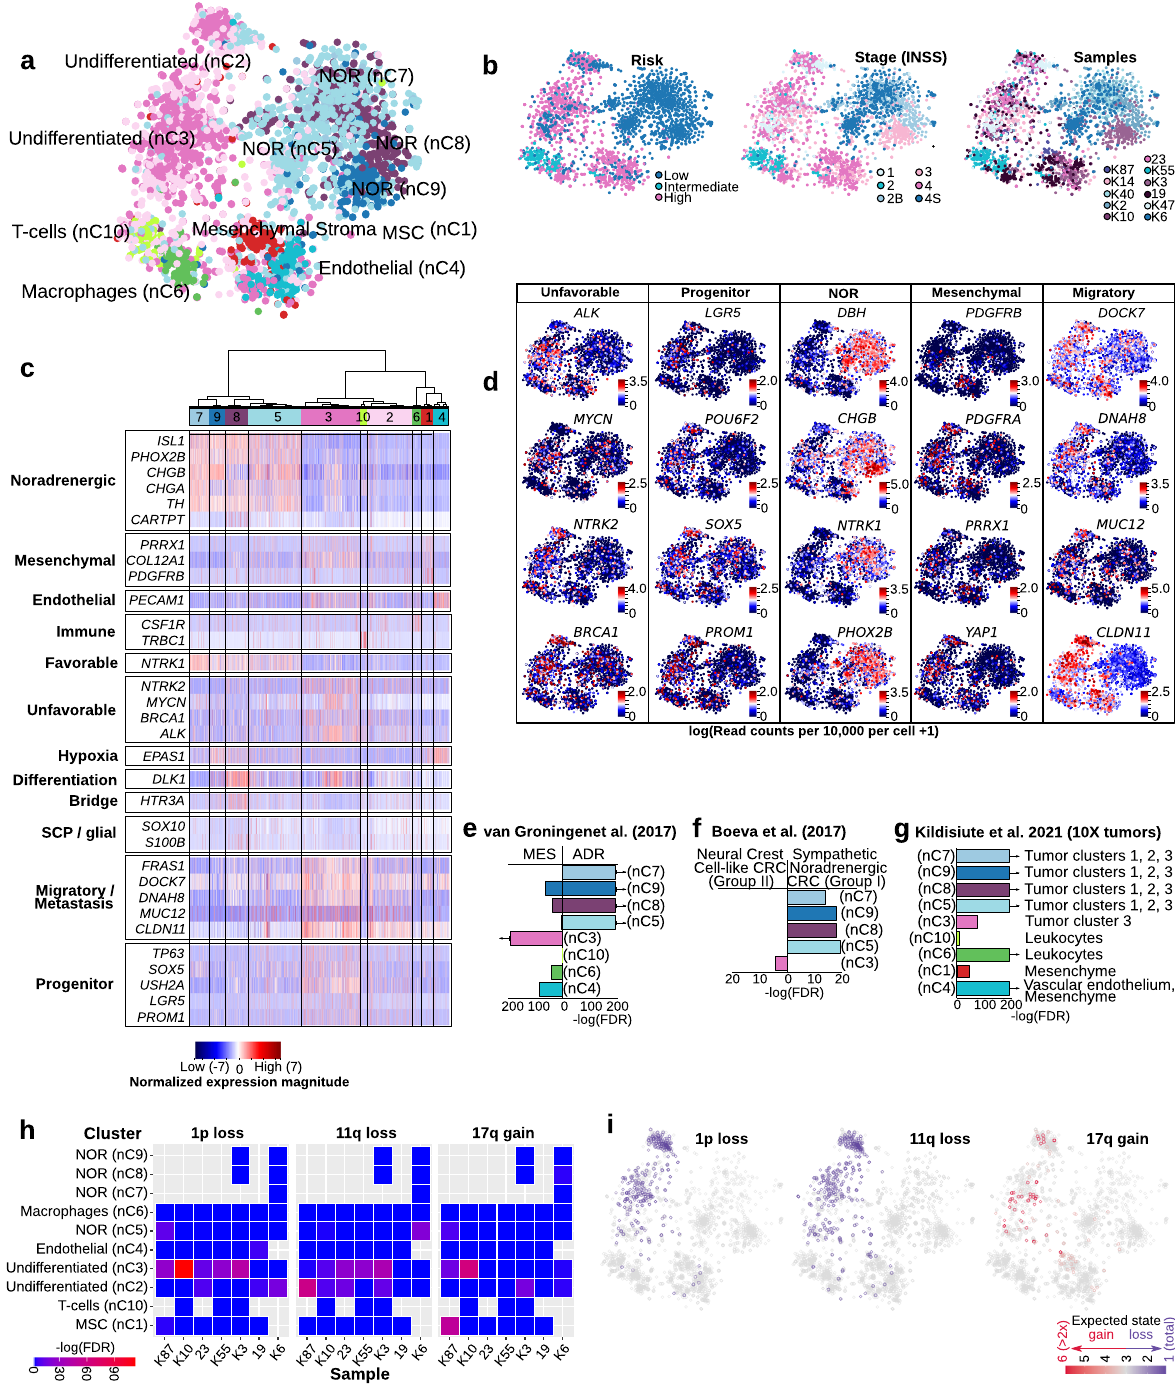
Different neuroblastoma risk groups present differences in cell population composition . Next, we used single-nuclei tran- scriptomics to characterize eleven neuroblastoma samples across different clinical risk groups, and genetic subsets (Fig. 3a, b, Supplementary Data 1). Deep-frozen samples obtained from surgical resections were used for nuc-Seq (SmartSeq2), yielding a total of 3212 high-quality nuclei with an average of 709,676 high- quality reads per nuclei (see “ Methods ” and Supplementary Fig. 1). Cluster analysis using PAGODA identi fi ed ten cell